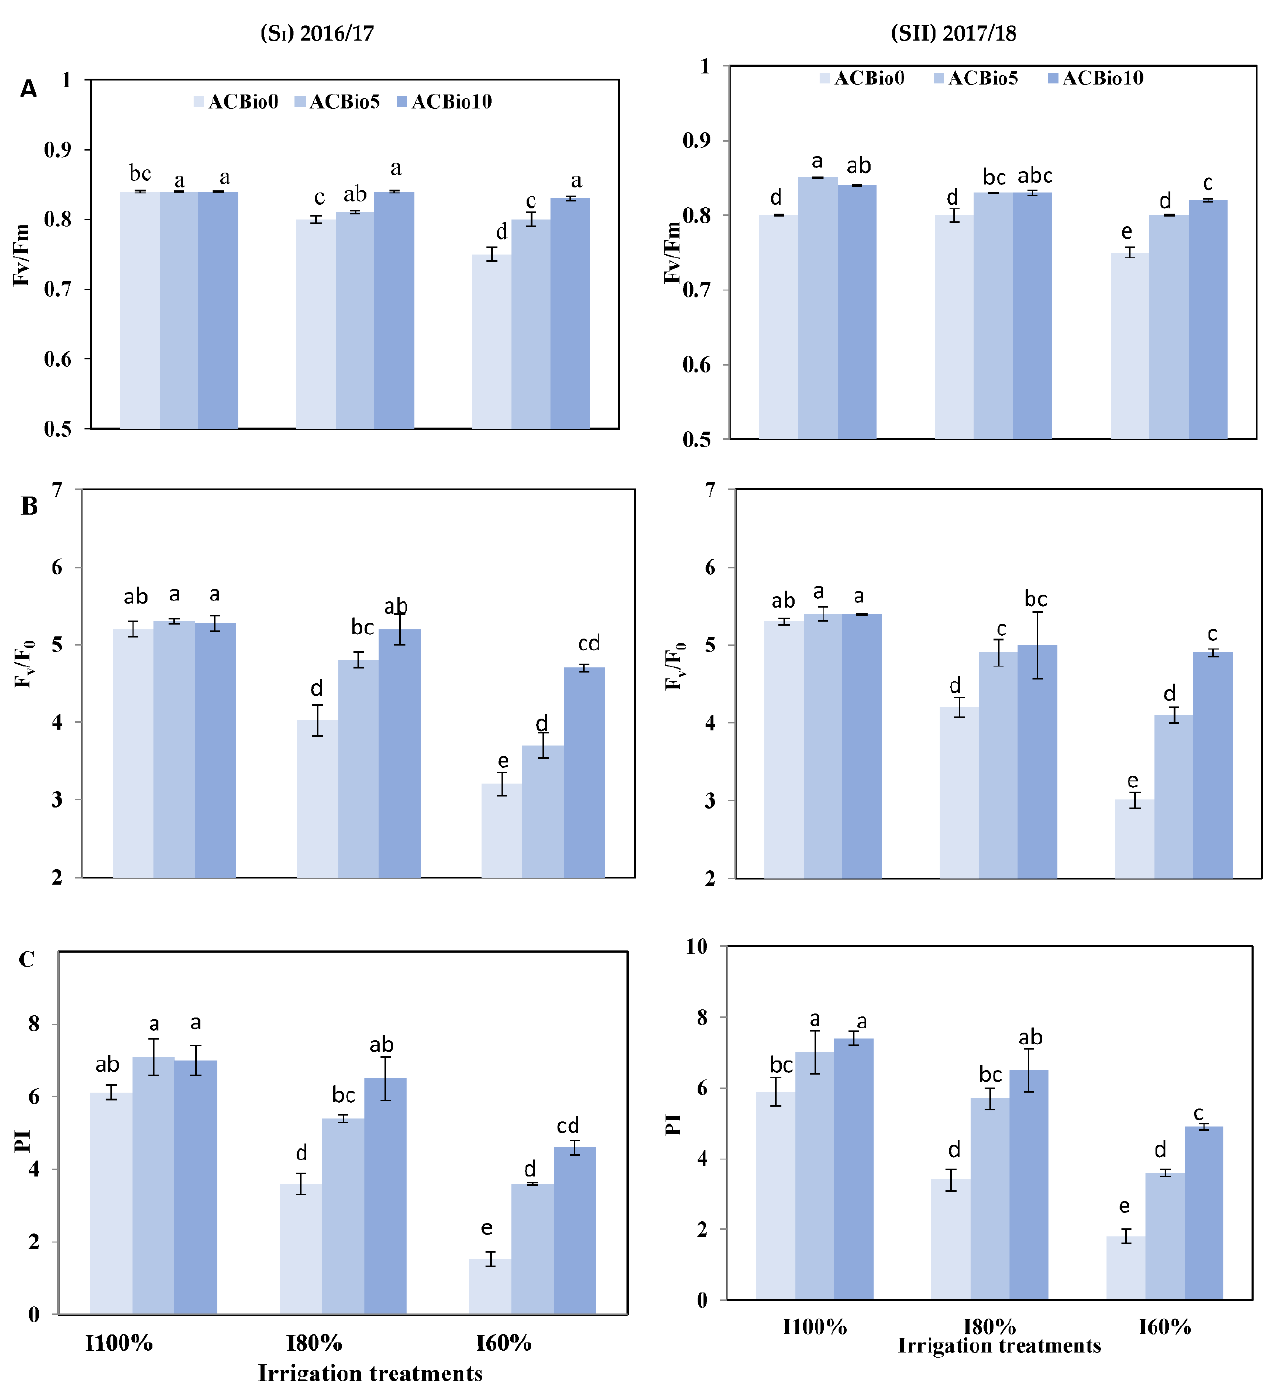
Figure 1. Leaf chlorophyll fluorescence parameter of faba bean plants grown under irrigation treatments (I 100 , irrigation with 100%; I 80 , irrigation with 80%; and I 60 , irrigation with 60% of ETc) and acidified biochar rates in 2016/17 and 2017/18 seasons. ( A ) Maximum quantum efficiency of PSII ( F v /F m ); ( B ) potential photochemical efficiency ( F v /F 0 ); and ( C ) performance index ( PI ). Vertical bars represent means of 3 replications ± S.E ( p ≤ 0.05). Columns marked by different letters are significantly different.